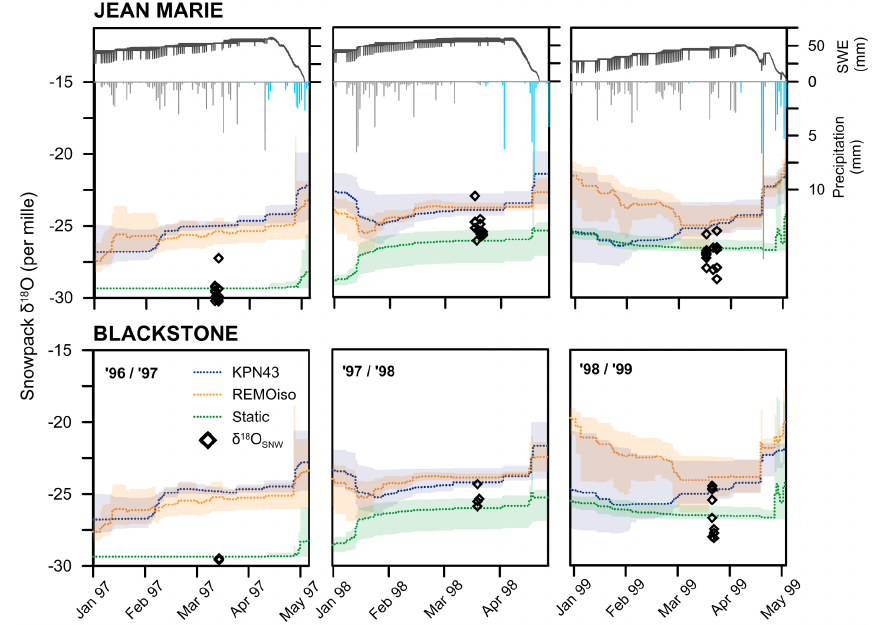
Figure 5. Precipitation-weighted δ 18 O of snowpack ( δ 18 O SNW ) for KPN43, REMOiso, and static inputs from January to the end of melt for each year of the study period. Snow water equivalent (SWE), snowfall (gray line), and rainfall (blue line) are also shown. δ 18 O ppt input- specific uncertainty bounds are represented as the shaded regions. Diamond symbols represent δ 18 O SNW observations sampled within each respective sub-basin during the GEWEX